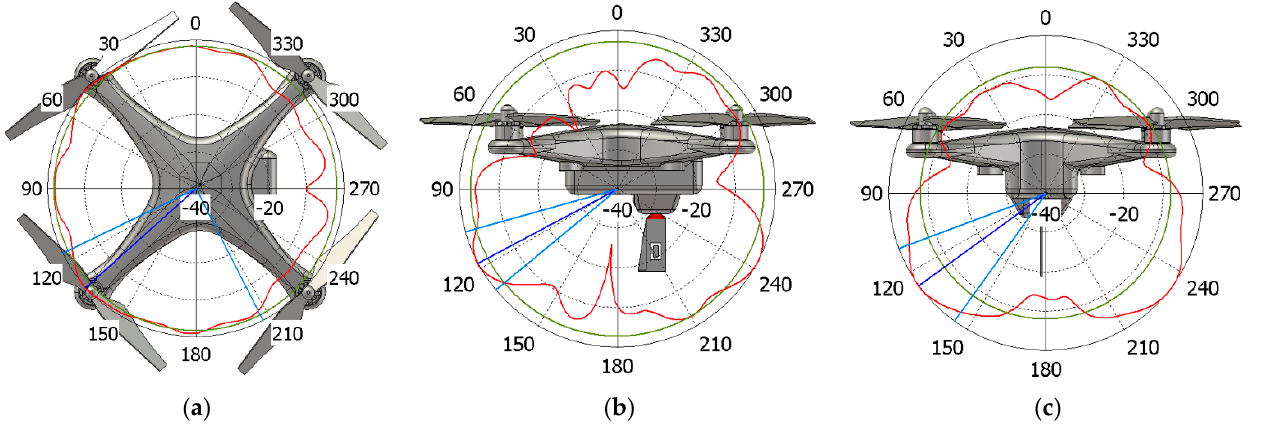
Figure 13. Normalized gain pattern (red line) for DJI Phantom 3 model at 3.5 GHz, ( a ) XY plane, ( b ) YZ plane and ( c ) XZ plane—CST Simulation Results in dB.